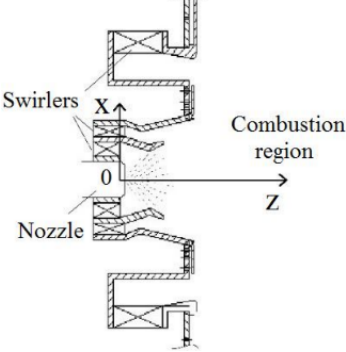
Figure 3. Structural diagram of swirl head.